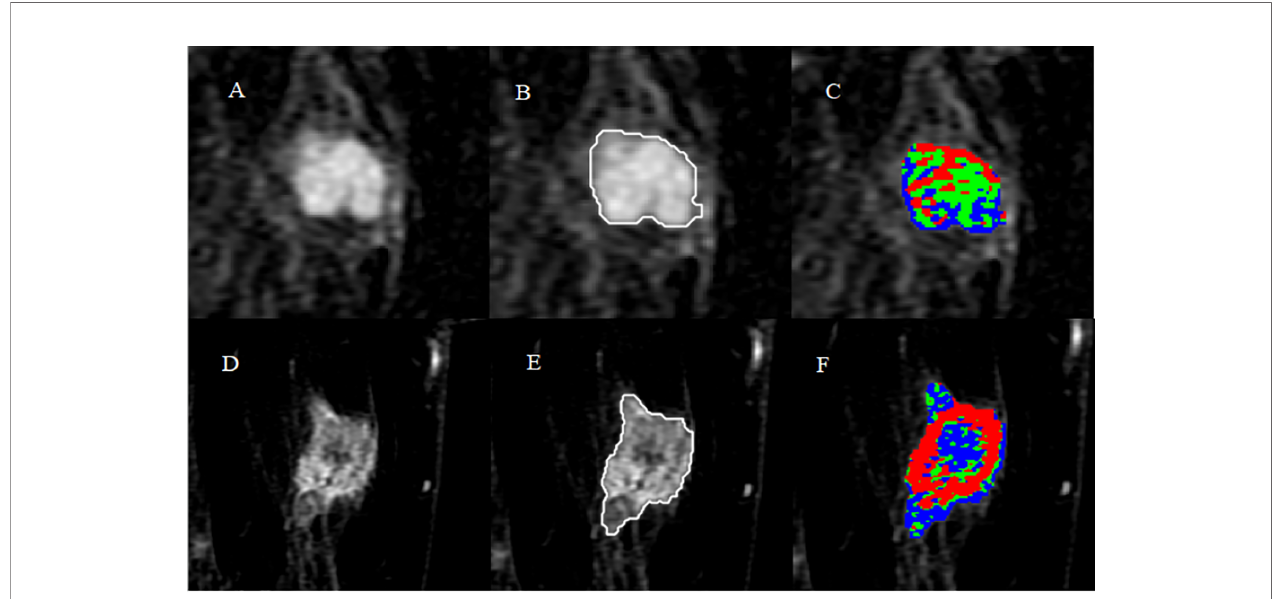
FIGURE 2 | Results of whole tumor segmentation and intratumoral subregion partition. The fi rst row shows the results of a benign case: (A) subtraction image with the maximum tumor diameter; (B) result of the whole tumor area segmented with a semi-automatic method; (C) result of intratumoral subregion partition, in which red, green, and blue represent the early, moderate, and late subregions, respectively. The second row shows the results of a malignant case: (D) subtraction image; (E) result of the whole tumor area; (F) result of intratumoral subregion